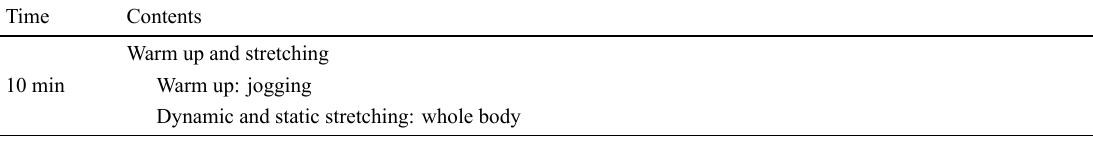
Lower abdomen: hip flexors cross-training (20 reps., 3–4 set, 30 sec.